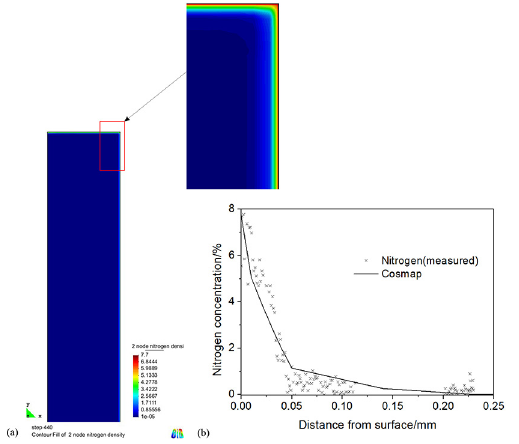
Figure 3. Simulated nitrogen concentrations by COSMAP.